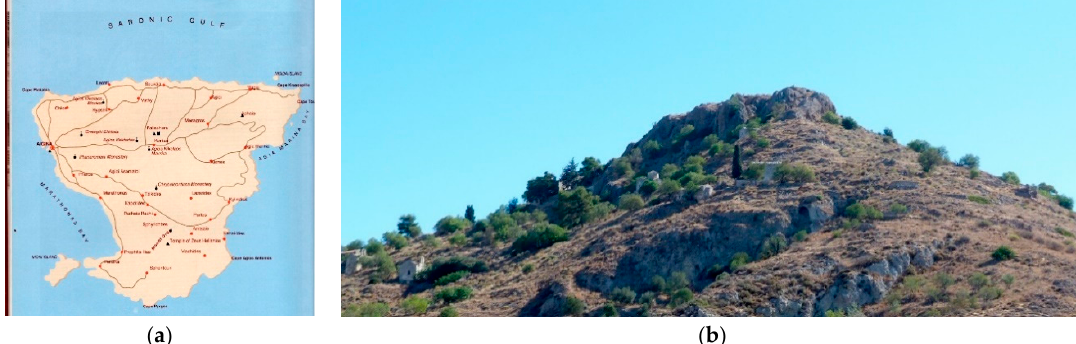
Figure 19. ( a ) The island of Aegina in the Saronic Gulf. Source: (Pennas 2005); ( b ) city of Paliachora on the top of a hill, island of Aegina. © Author.